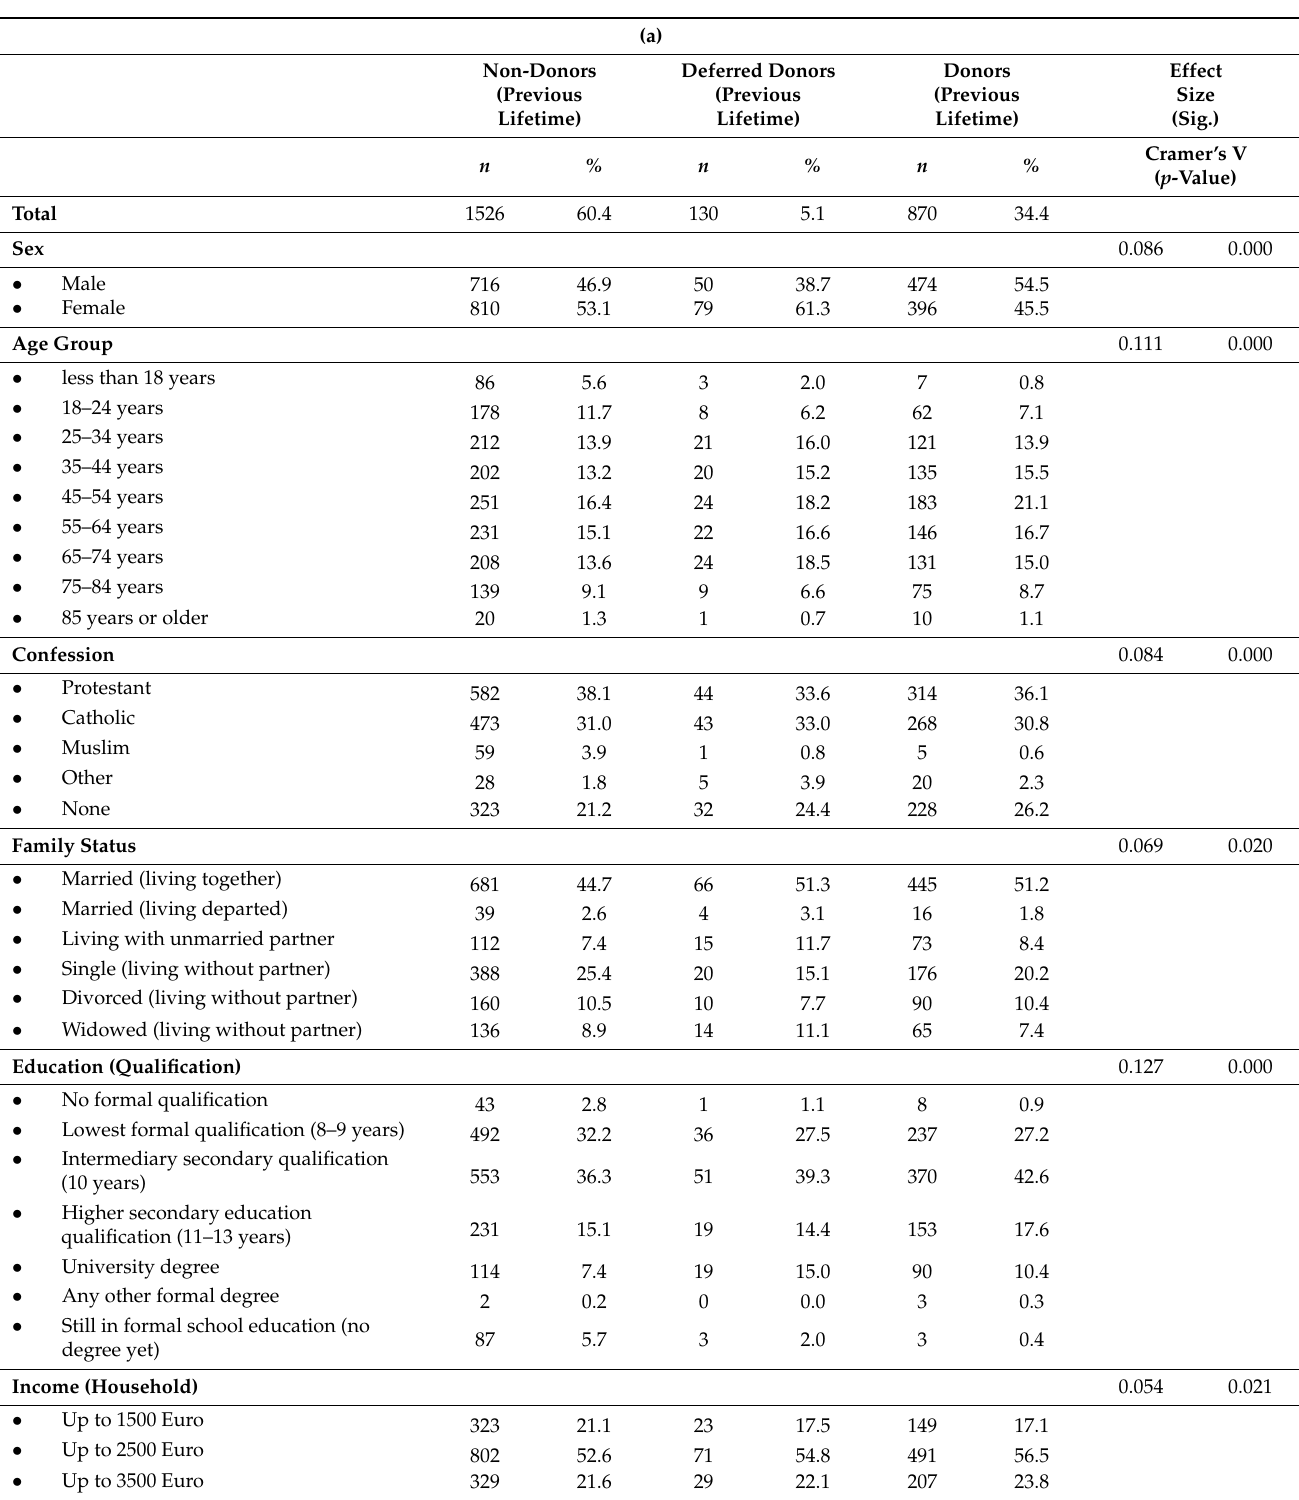
Table 2. ( a ) Socio-demographic characteristic of past non-donors, deferred donors, or donors ( n = 2531, weighted) *. ( b ) Socio-demographic characteristic of non-intenders and intenders ( n = 2531, weighted)